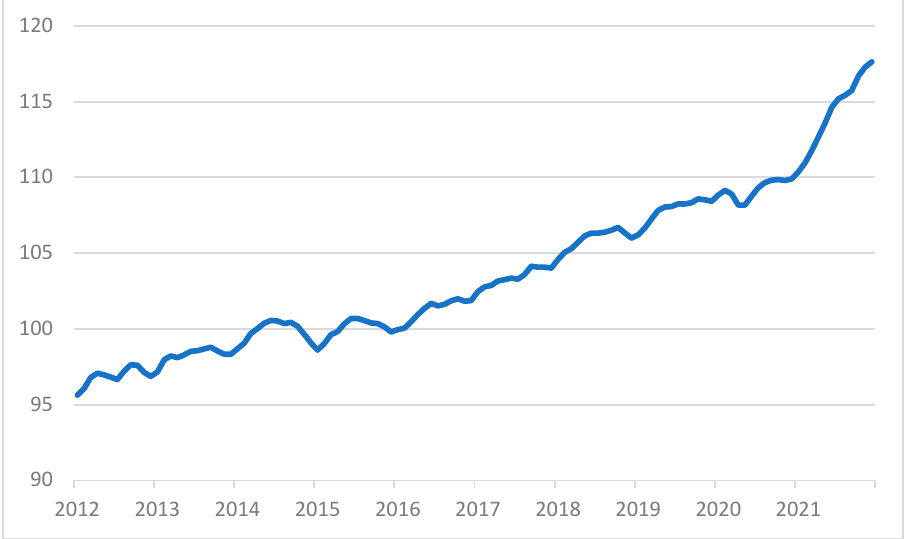
Figure 2. U.S. Consumer Price Index (2015 = 100), 2012–2021. Source: Created by the Authors. In Figure 3, we display the U.S. unemployment rate over the survey period (U.S. Bureau of Labor Statistics 2022). For the majority of the period U.S. employers were adding jobs and the labor market was becoming significantly tighter with the unemployment rate decreasing from 8% to 3%. While the COVID-19 pandemic resulted in a large spike to unemployment, this has been short-lived with unemployment decreasing to the 3% range by end of 2021.